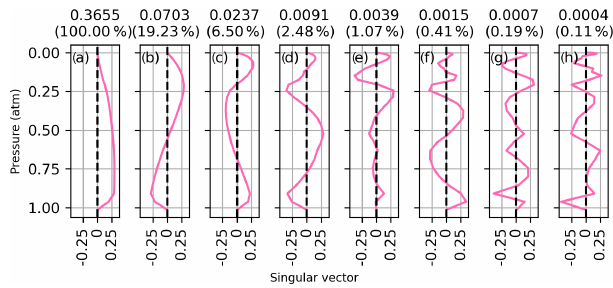
Figure D5. Same as Fig. D1 but for the Weak2